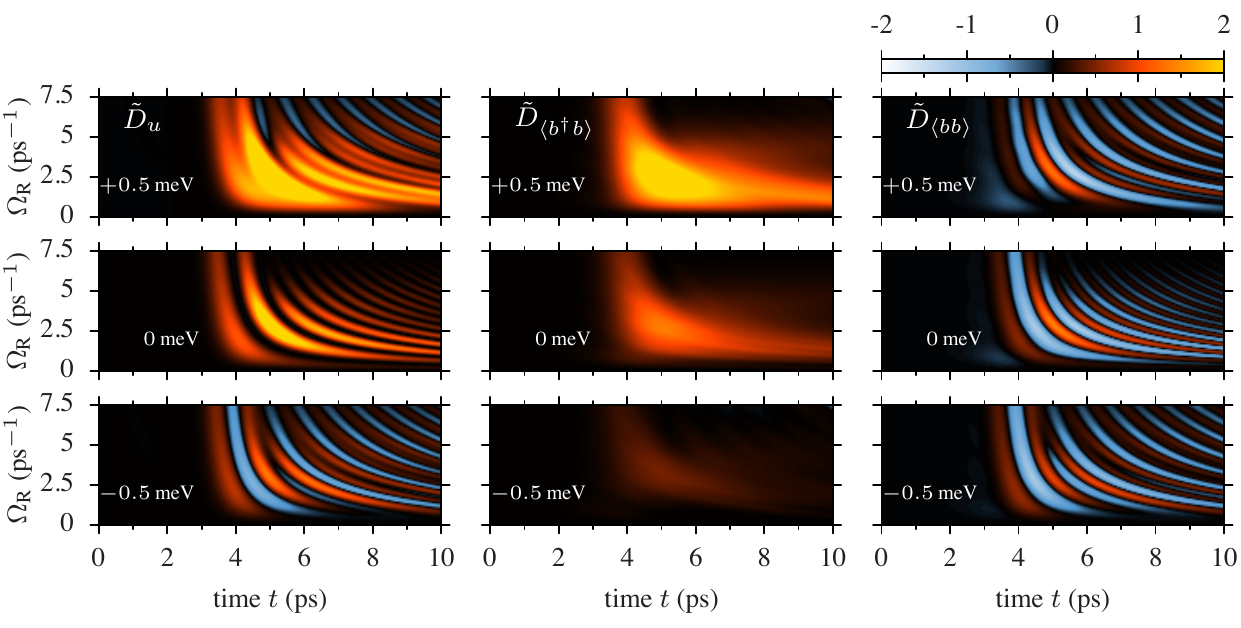
Figure 5. Fluctuations of the lattice displacement ˜ D at r = 20 nm plotted against time t and Rabi frequency Ω (top); 0 meV (middle) and